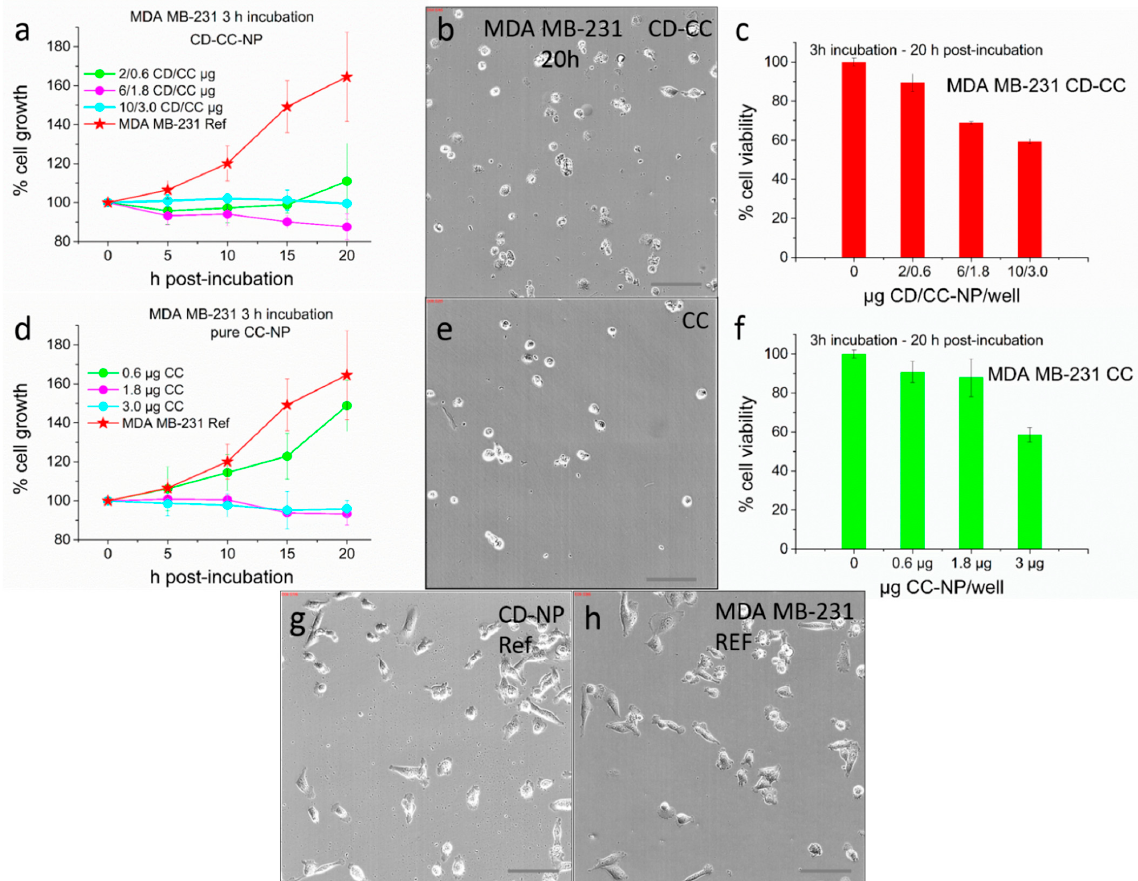
Figure 10. Effect of curcumin on MDA MB-231 cells after 3 h incubation followed by 20 h post-incubation: ( a – c ) CC delivered in CD-CC-NP, ( d – f ) treated with pure CC-NP. ( b , e , g , h ) Bright field images after 20 h post-incubation, cells treated with ( b ) 3 µg CC in CD-CC-NP, ( e ) 3 µg CC as CC-NP, ( g ) 10 µg CD-NP/well, ( h ) untreated reference, scale bar: 100 µ. ( a , d ) Cell proliferation obtained by cell counting, ( c , f ) CCK-8 assay after 20 h post-incubation. 2.11. Cell Studies: Non-Cancerous Human Mammary Epithelial Breast Cell Line MCF-10A Common anti-cancer treatments are usually non-discriminately aggressive against all cell lines and often induce severe side-effects. We have included a non-cancerous cell line in our studies to evaluate the cytotoxic effect of curcumin towards healthy cells. Ex- posure conditions to CD-CC-NP and CC-NP were set to 3 h incubation and 48 h post- incubation, the maximum values used for the cancer cell lines discussed above. In none of the four independent experiments performed did we encounter comparable mortality rates as observed for any of the other cell lines described above. In fact, even with the highest concentration of curcumin of 3 µg/well, we encountered at most a 30-40% mortal- ity. In Figure 11a we compare the cell proliferation (cell counts) after 24 h post-incubation (green bars) to the starting conditions (after medium change, 0 h, red bars). The treatment does show a suppression of cell growth upon exposure to free CC-NP, CD-CC-NP or even CD-NP, while untreated cells grow by about 165% during this time period. However, most of the cells are still alive (grey bars). The good survival of MCF-10A cells under the highest CD-CC-NP concentration even after 48 h is seen in the images in Figure 11b. Sub- stantial CD-CC-NP particle uptake has taken place, but cells are mostly alive. Only in one instance did we recognize even here the formation of vacuoles, only in 2 wells upon ex-